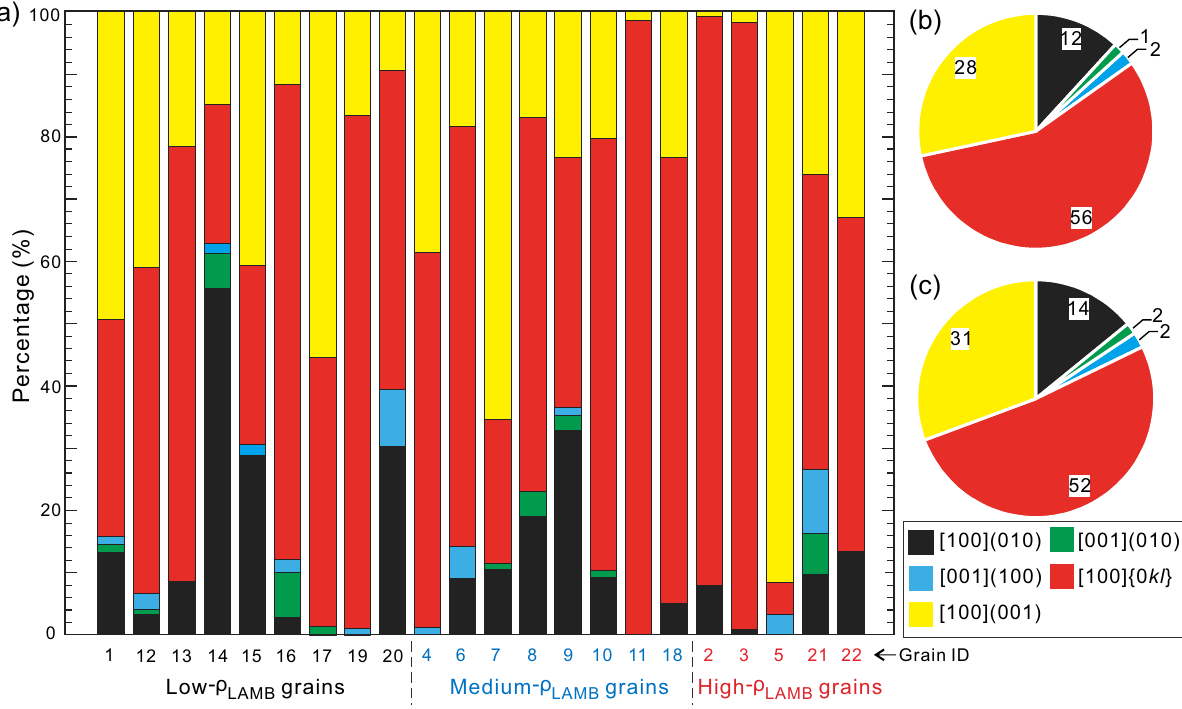
Figure 5. ( a ) Percentages of 5 dislocation slip systems in the 22 analyzed olivine grains. The average proportions of five slip systems are calculated in two ways: ( b ) first calculating the proportions of SGBs related to each of the 5 slip systems in each grain, then averaging them, and ( c ) first summing the length of SGBs related to each of the 5 slip systems in all grains, then calculating their averages. Results are derived from the step size of 1